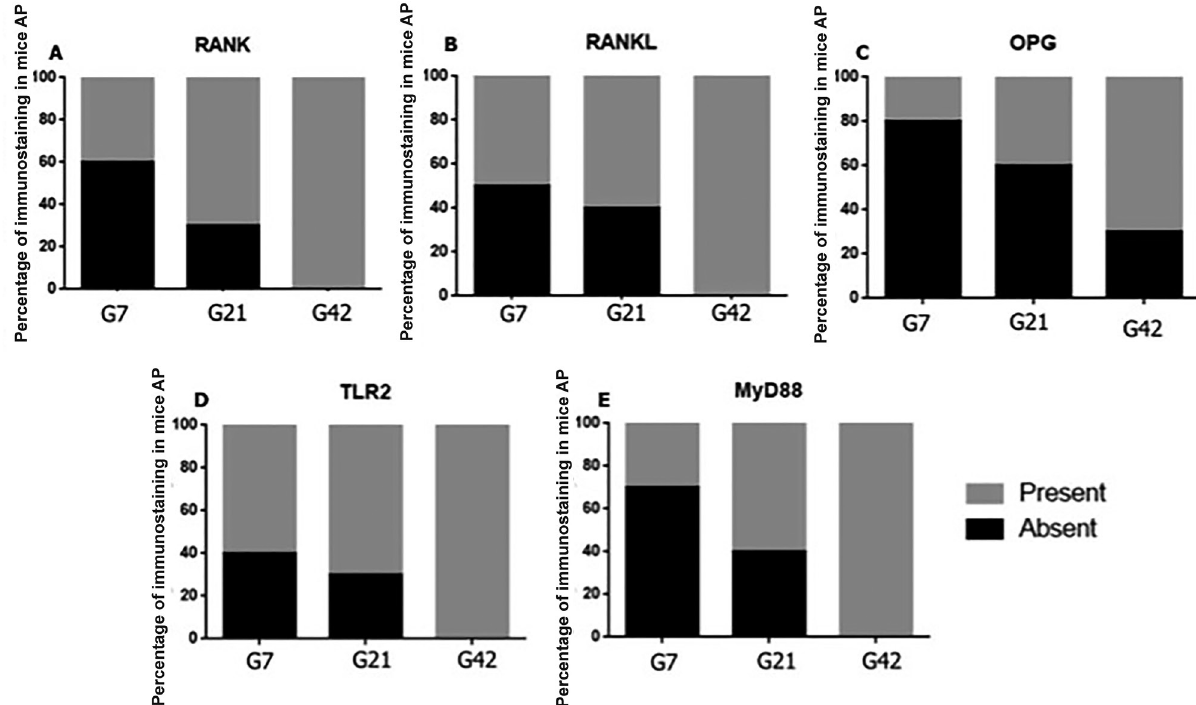
Figure 3- Graphical representation of immunostaining distribution (presence or absence) RANK (A), RANKL (B), OPG (C), TLR2 (D) and MyD88 (E) in the wild-type mice after periapical lesion induction in the periods of 7, 21 and 42